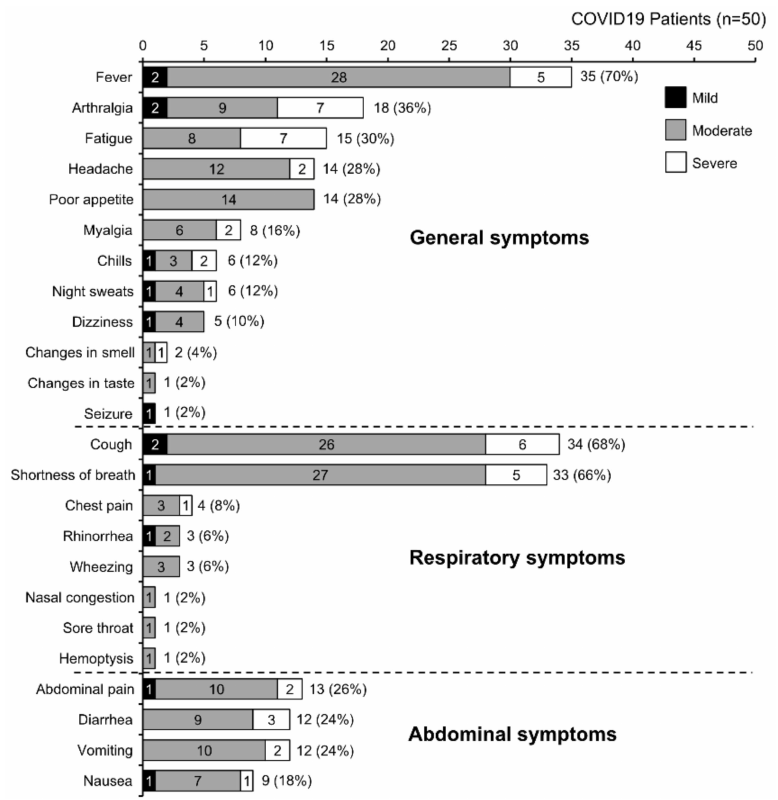
Figure 1. Symptom frequency among the patients in the COVID-19 group. Table 3. Medications administered during COVID-19